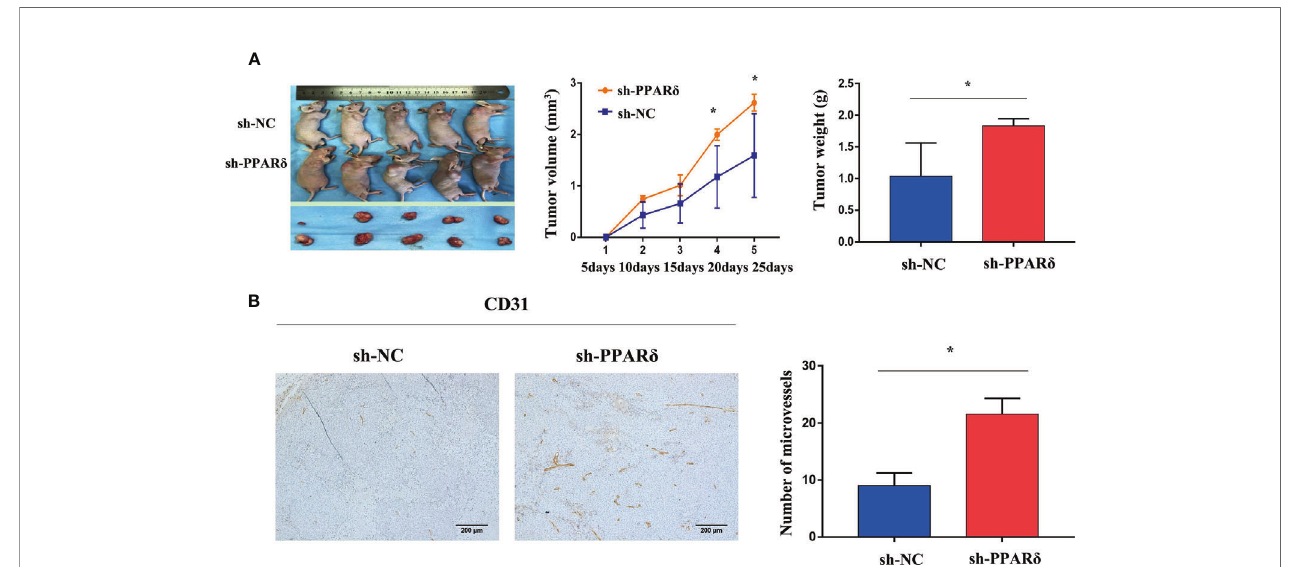
FIGURE 3 | Knockdown of PPAR d promotes nude mice tumor growth and angiogenesis. (A) Representative images of tumor-bearing mice and tumor masses. Tumor growth curves were generated. Xenografts ’ volumes were measured every 5 days in a 25-day period. (B) Representative IHC staining images of CD31 in subcutaneous tumors of nude mice. Scale bars, 200 m m (magni fi cation, 100×). Average tumor weight and microvessels ’ number in each group. Data represent the mean ± SD, *P <